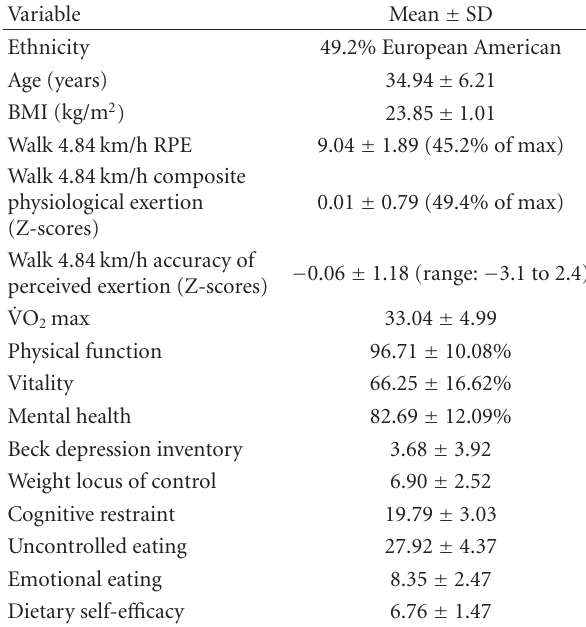
Table 1: Characteristics of the study